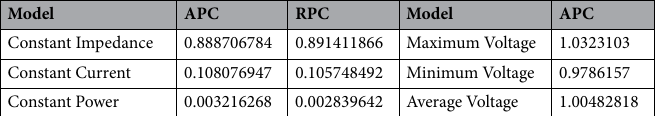
Table 11. Trinitaria ZIP static load model coefficients and Voltage bus values.